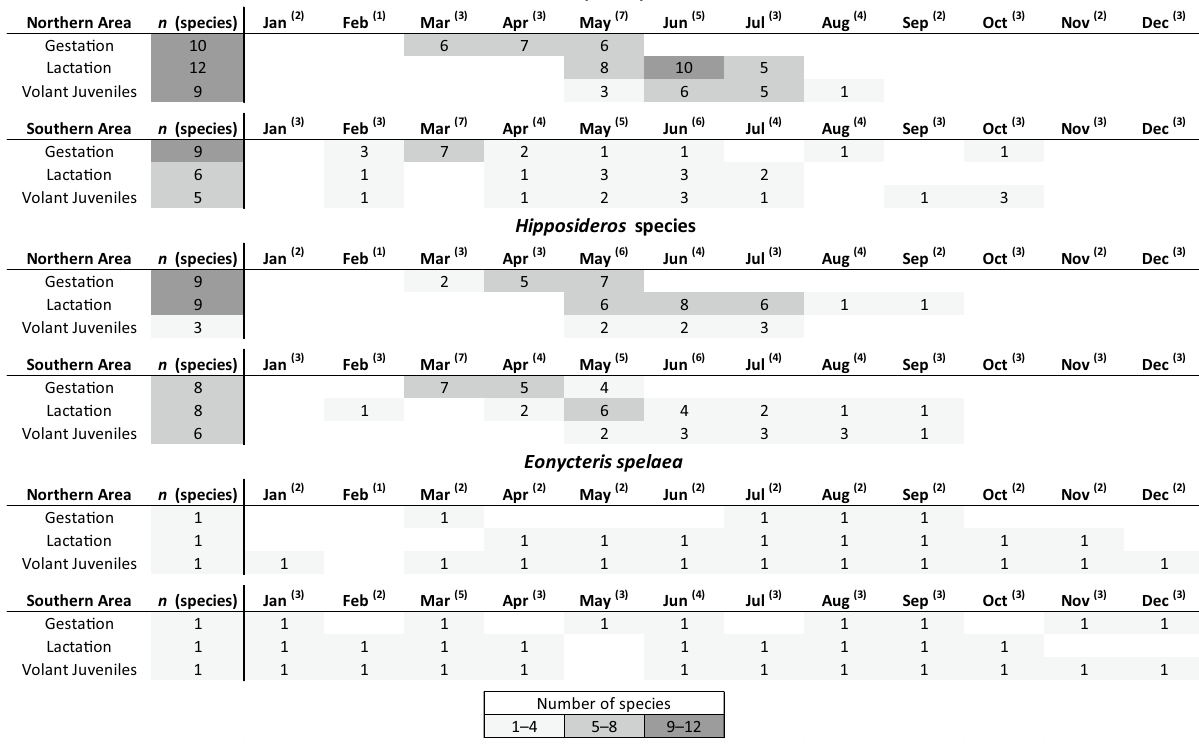
Figure 4. Summary of available data on the reproductive phenology of Rhinolophus, Hipposideros and Eonycteris species in mainland southeast China, Vietnam, Laos and Cambodia. The chart shows the number of species for which a reproduction phase has been observed in a given month of the year for the northern (above 16° N) and southern (below 16° N) portions of the region. Each cell is shaded proportionally according to the number of species for which data were retrieved during the literature review, whereas superscript figures refer to the number of studies for which reproductive data were available for the genus in a given